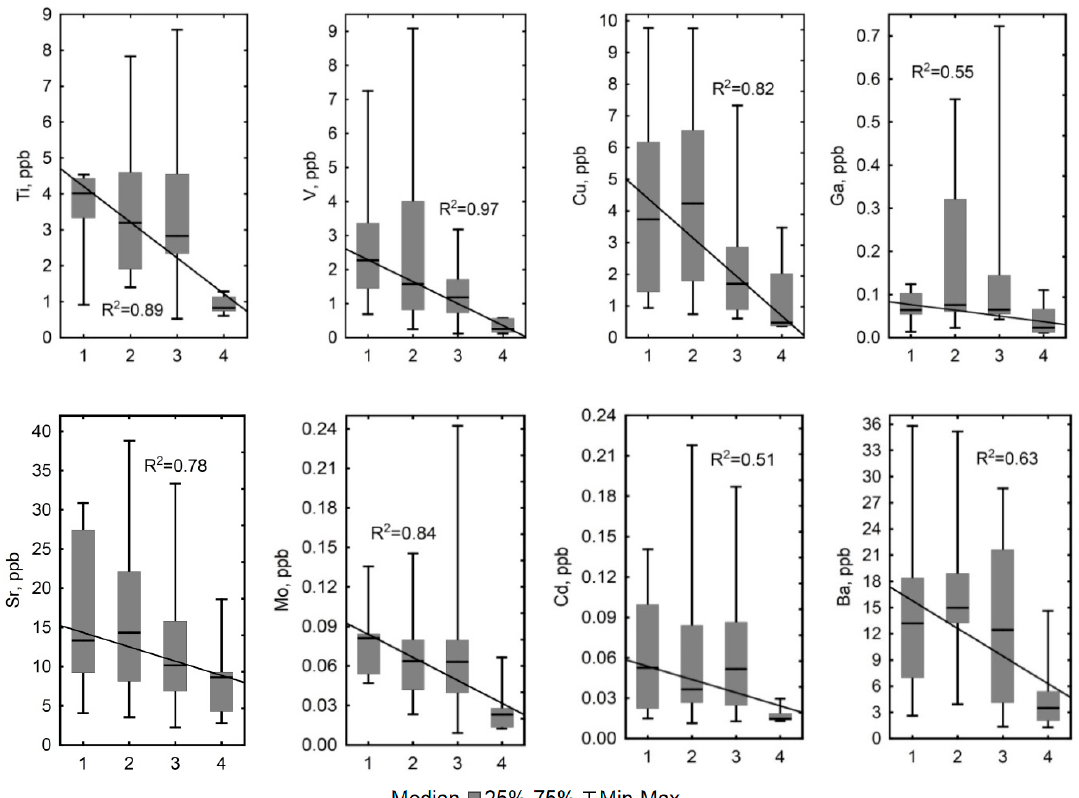
Figure 6. Some chemical parameters exhibited a clear trend in decreasing values (0.63 < R 2 < 0.97, p < 0.05) in bog waters of the KS Tazovsky (Taz) microtopes with different hydrological regime: 1—polygons occupying elevated dry positions; 2—degraded and flooded polygons and small cracks between polygons; 3—large cracks and fens without a watercourse; 4—lower parts of the fens with a watercourse. The solid line is a linear fit to all data with the regression equation given on each graph. It should be noted that the categories (1–4) are becoming increasingly wet from left to right.